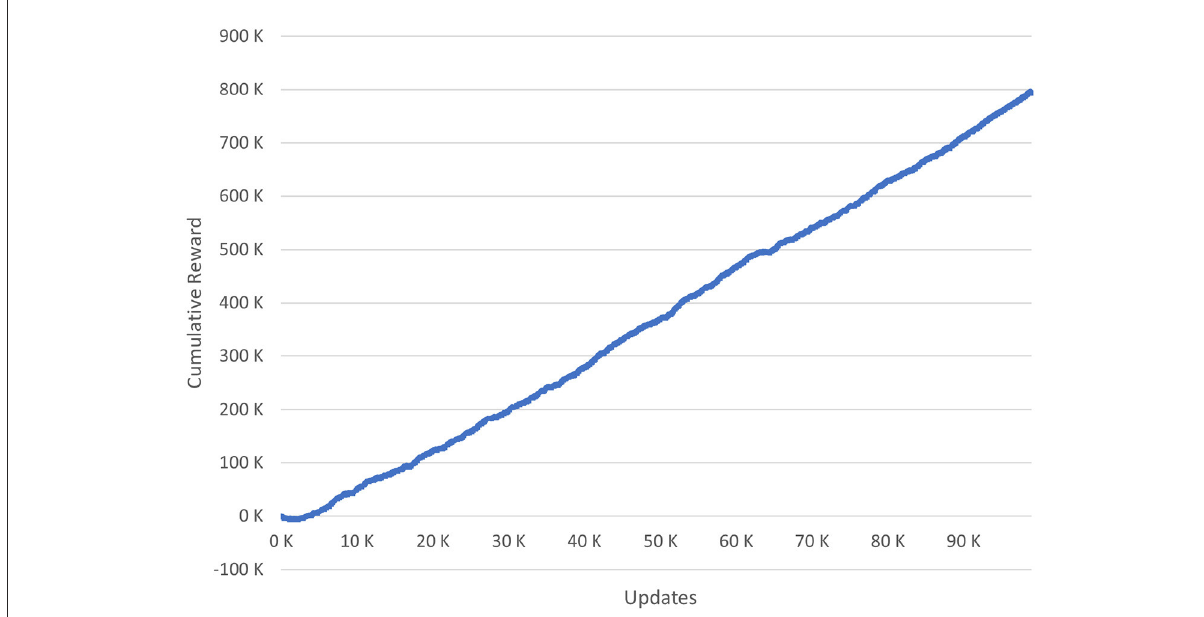
FIGURE5 The cumulative reward of the simulation.